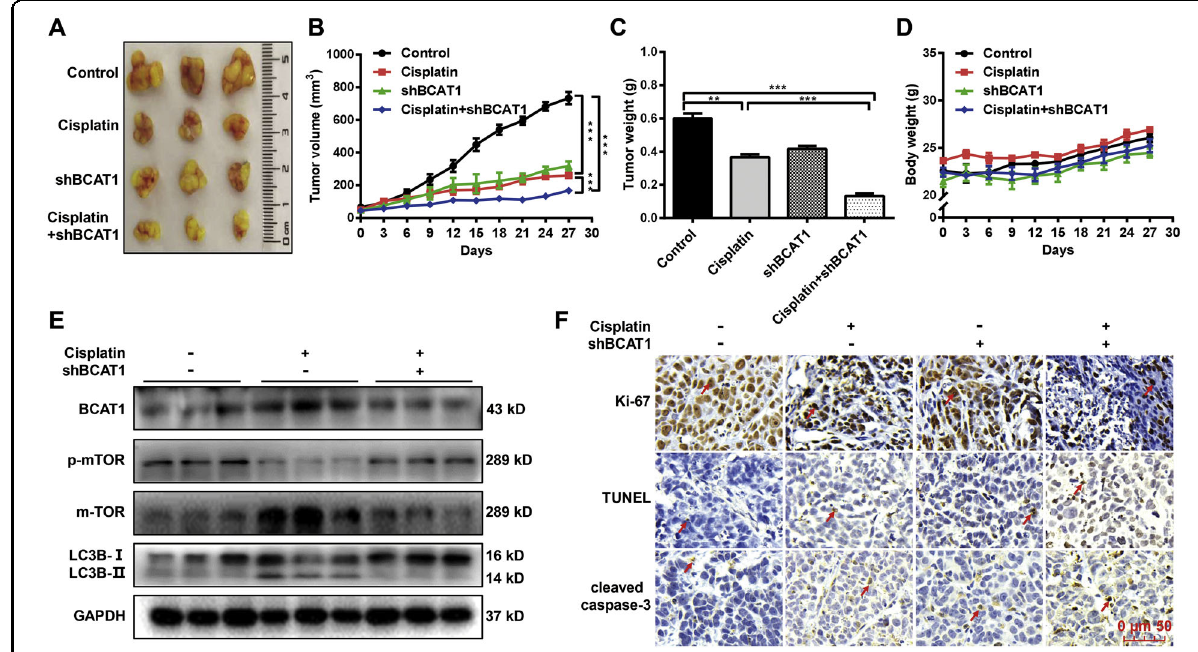
Fig. 6 Knockdown of BCAT1 increases cisplatin sensitivity in vivo. A Representative images of the xenograft tumors ( n = 5). HepG2 cells with BCAT1 knockdown by shBCAT1 or control cells were subcutaneously implanted into nude mice. Seven days later, the mice were treated daily with intraperitoneally injections of the diluents or cisplatin for 27 days. B Tumor volume was measured and calculated every 3 days (n = 5). C The fi nal tumor weight was measured ( n = 5). D The body weight of mice was measured every 3 days ( n = 5). E The protein expression levels of BCAT1, LC3B- I/II, mTOR, and phosphorylated mTOR were examined in the tumor tissues by Western blot. F IHC staining of Ki-67 and cleaved caspase-3 and TUNEL assay. The arrow represents a positive signal. Scale bars: 50 μ m. ** P < 0.01, *** P <